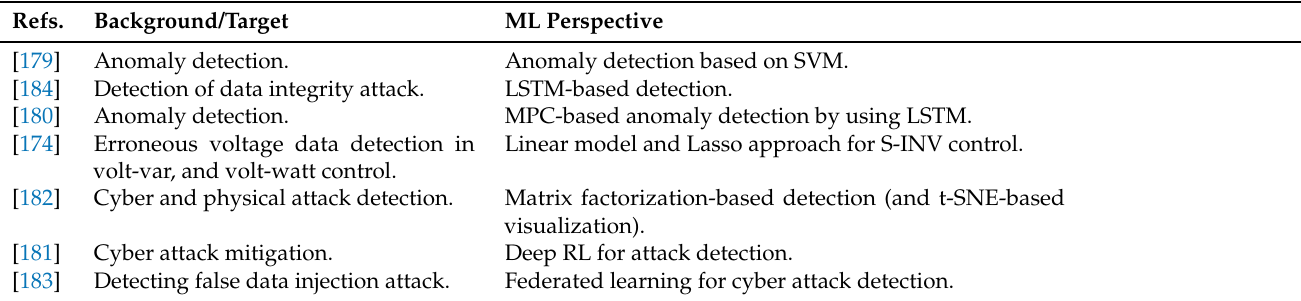
Table 6. Relevant studies on cyber security of S-INVs.